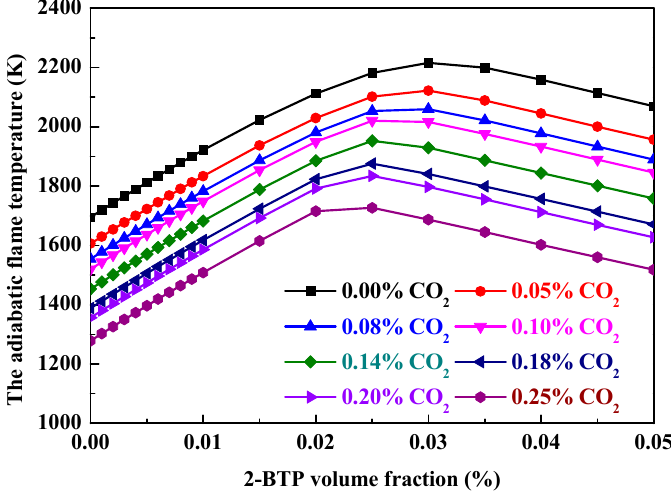
Figure 8. The dependence of adiabatic temperature on 2-BTP volume fraction with varying CO 2 addition in Φ = 0.6 moist C 3 H 8 /air flames at 298 K and 1 bar.